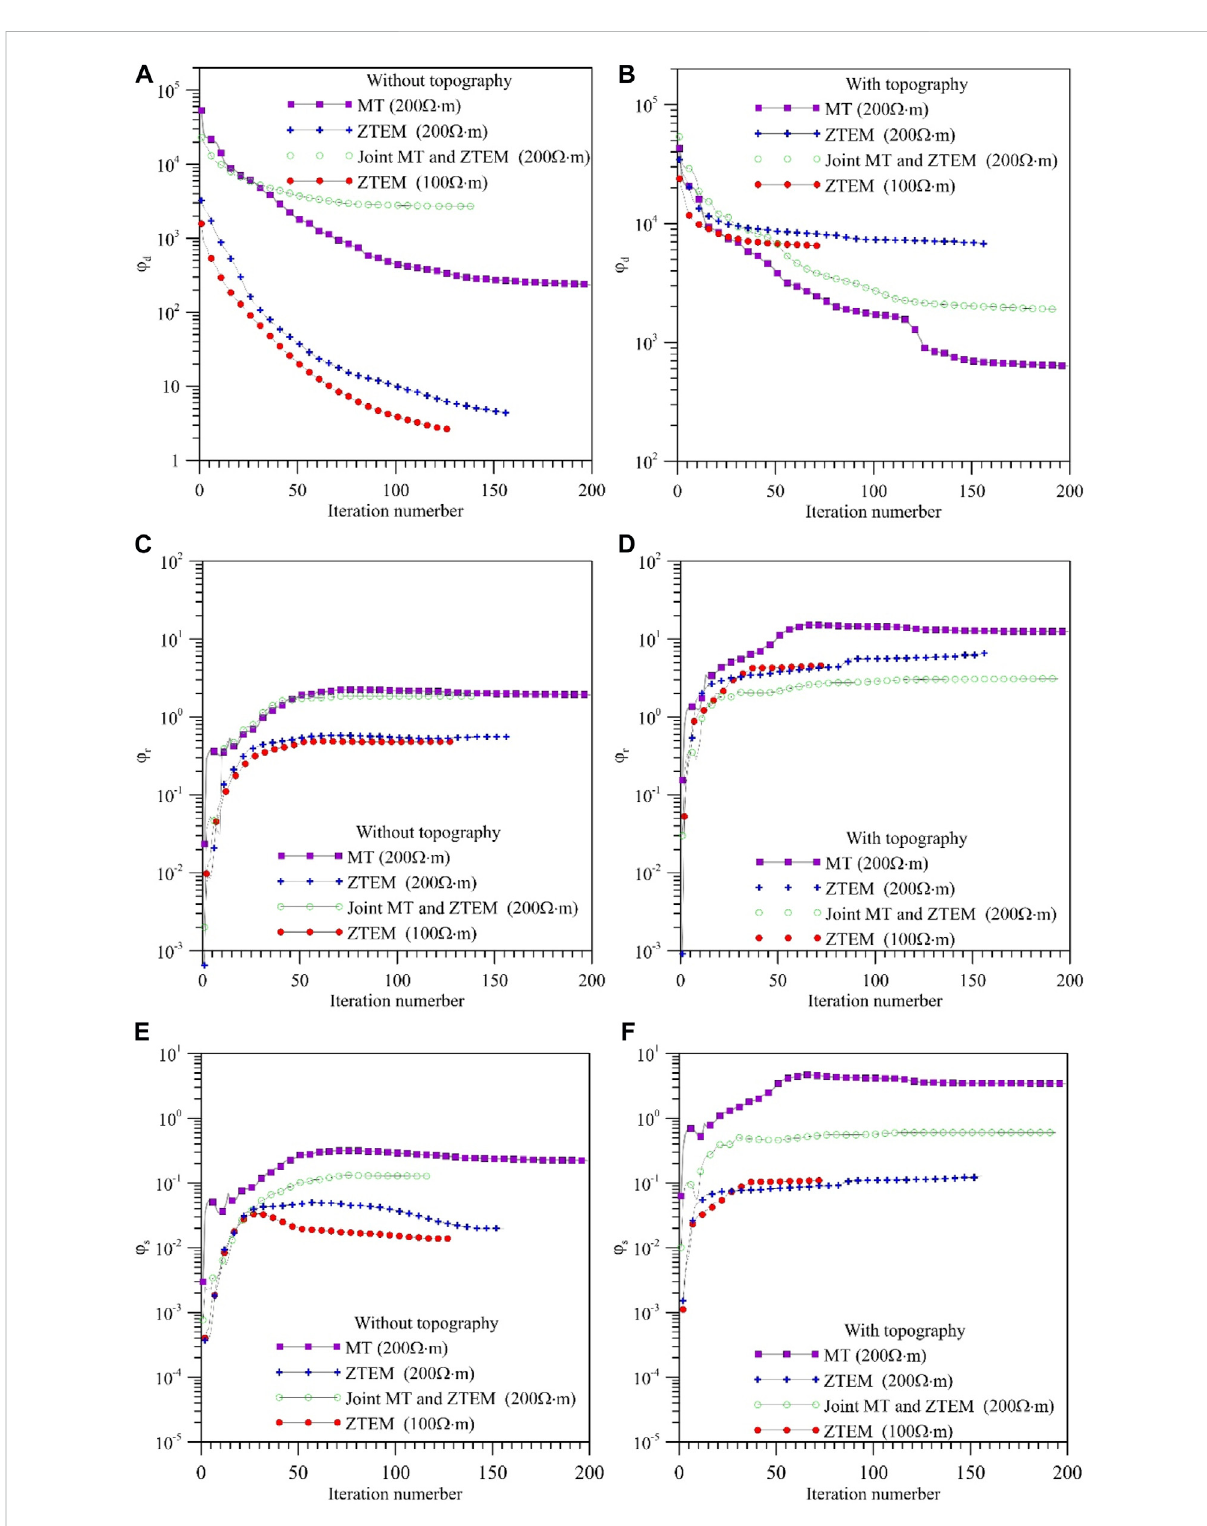
FIGURE 7 (A,B) Data mis fi t φ d , (C,D) model roughness measures φ r , and (E,F) smallness measures φ s versus